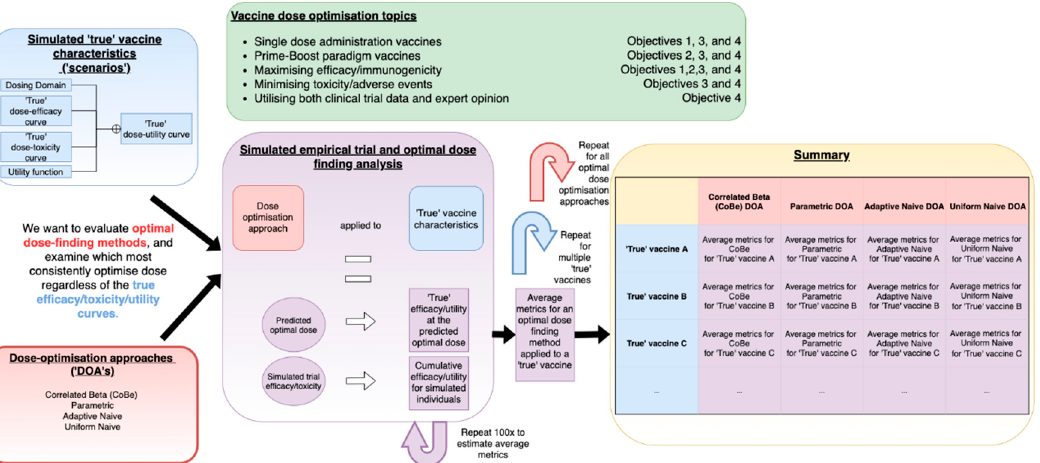
Figure 1. A visual depiction of the process of conducting simulation studies used in this work to evaluate the Correlated Beta (CoBe) and other potential approaches of vaccine dose optimisation (red). These were tested by simulating clinical trials (purple) based on ‘scenarios’ (blue). Repeated simulation of clinical trials was conducted for different dose-optimisation approach/scenario pairs, and metrics related to how effectively optimal dose was located were calculated. These were tabulated and compared to assess these approaches. These analyses were used with considerations of several open topics in vaccine dose-optimisation (green).